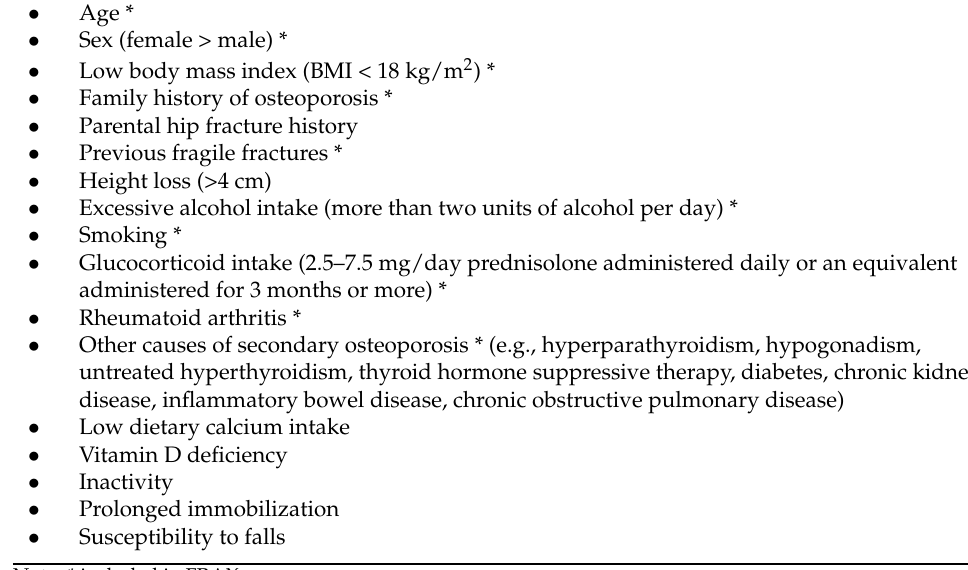
Table 1. The main osteoporosis risk factors